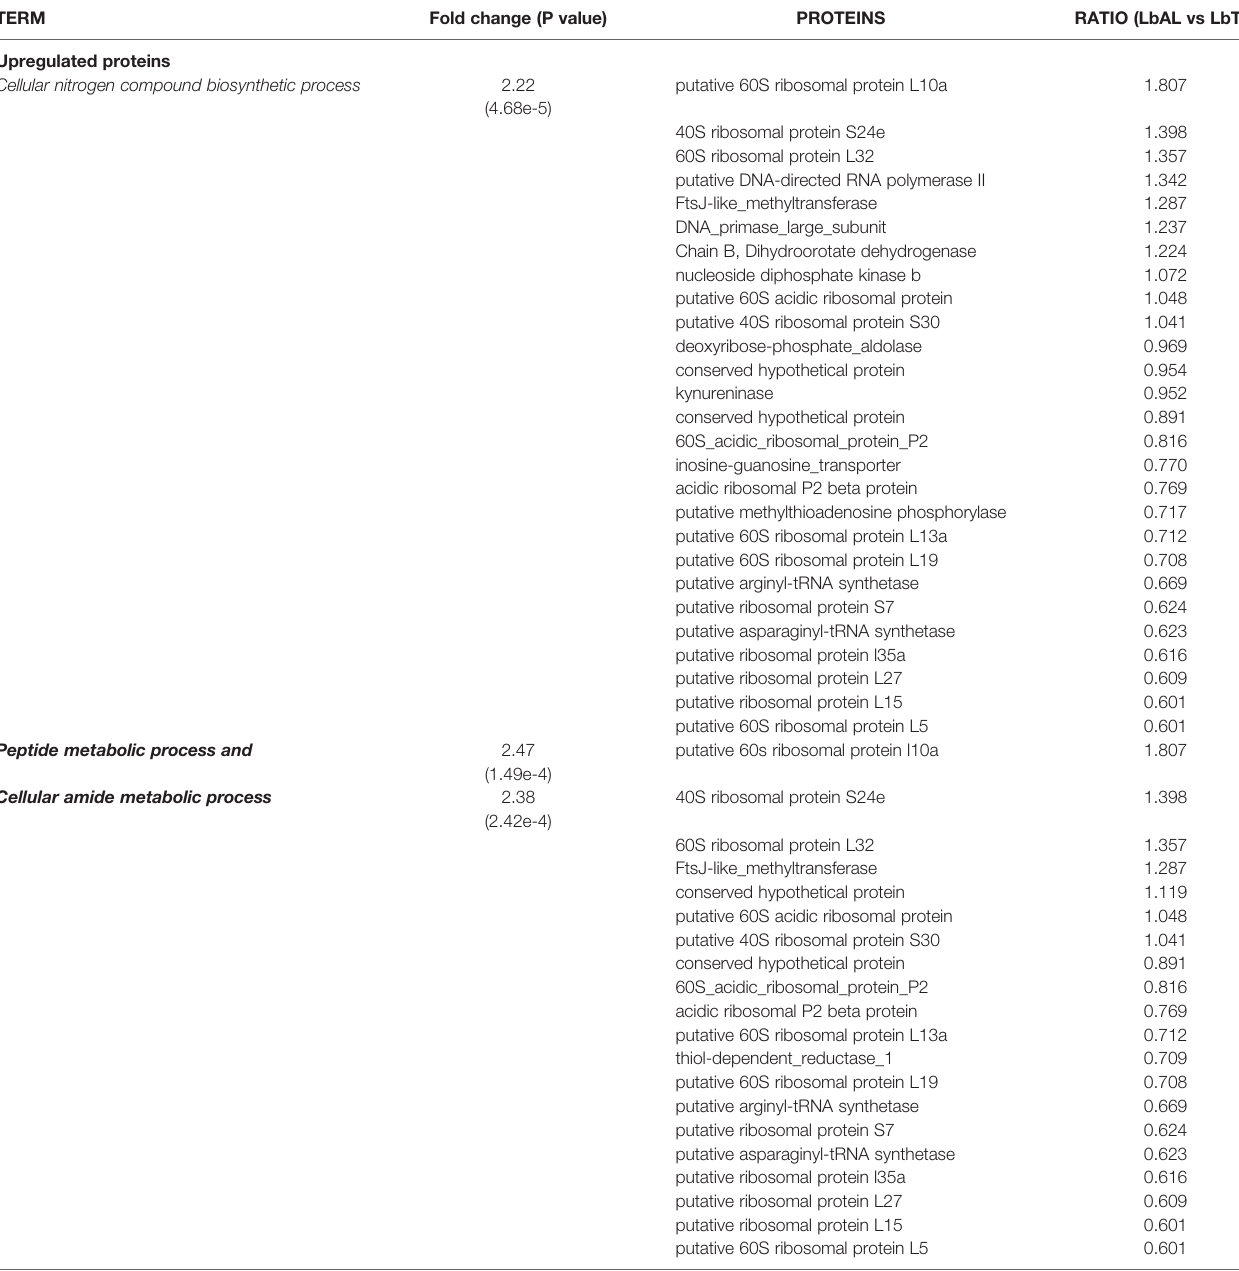
TABLE 2 | Gene Ontology (GO) enrichment analysis of Biological Process in differentially regulated proteins in L. braziliensis from atypical lesion (LbAL) compared to L. braziliensis . Proteins sorted by log2-ratio.